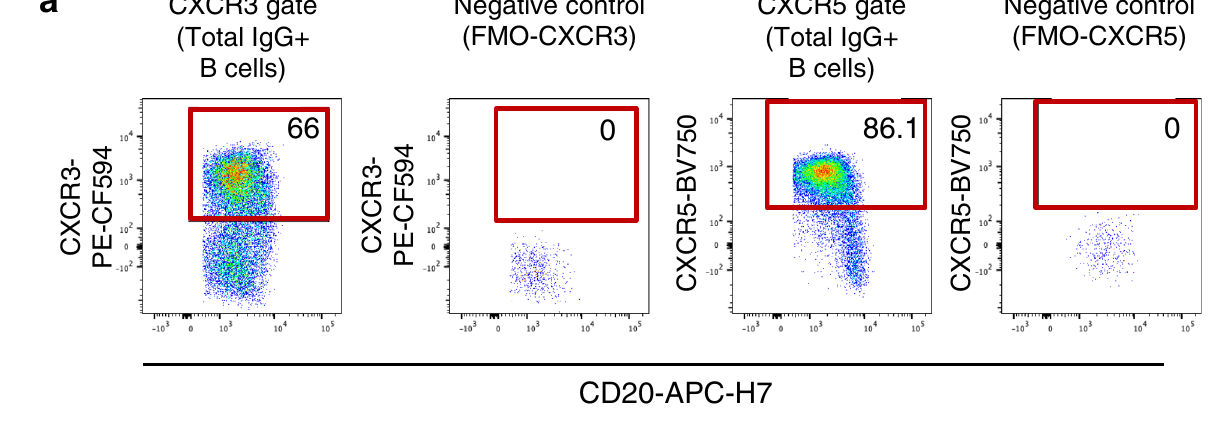
Fig.5|HCV-speci fi cmemoryBcellsexpressaliver-homingchemokinereceptor pro fi le. a Representative fl ow cytometry plots illustrating CXCR3 and CXCR5 expression on IgG+ B cells. FMO, fl uorescence-minus-one. b The frequencies of CXCR3+ (liver-homing) IgG+ B cells from patients with chronic HCV infection ( n =42) and uninfected controls ( n =17), and of CXCR3+ HCV-speci fi c IgG+ B cells from patients with chronic HCV infection ( n =27) were compared (left panel). The CXCR3 geometric mean fl uorescent intensity (MFI) of IgG+ B cells from patients with chronic HCV infection ( n =42) and uninfected controls ( n =17), and of HCV- speci fi c IgG+ B cells from patients with chronic HCV infection ( n =29) were com- pared (right panel). c The frequencies of CXCR3+(liver-homing)B cells(left panel) and their CXCR3 MFI (right panel) were compared in paired blood and liver spe- cimens of patients with chronic HCV infection ( n =7 paired samples in left panel, n =8 in right panel). d The frequencies of CXCR5+ (lymph node-homing) IgG+ B